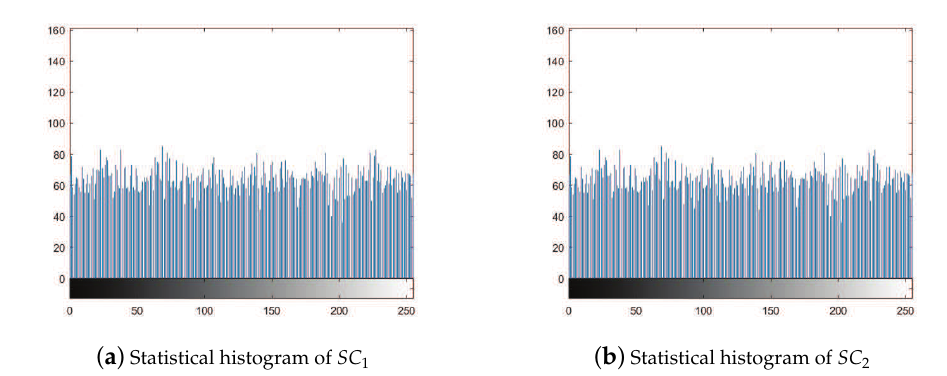
Figure 8. Statistical histogram of shadow images generated in Experiment